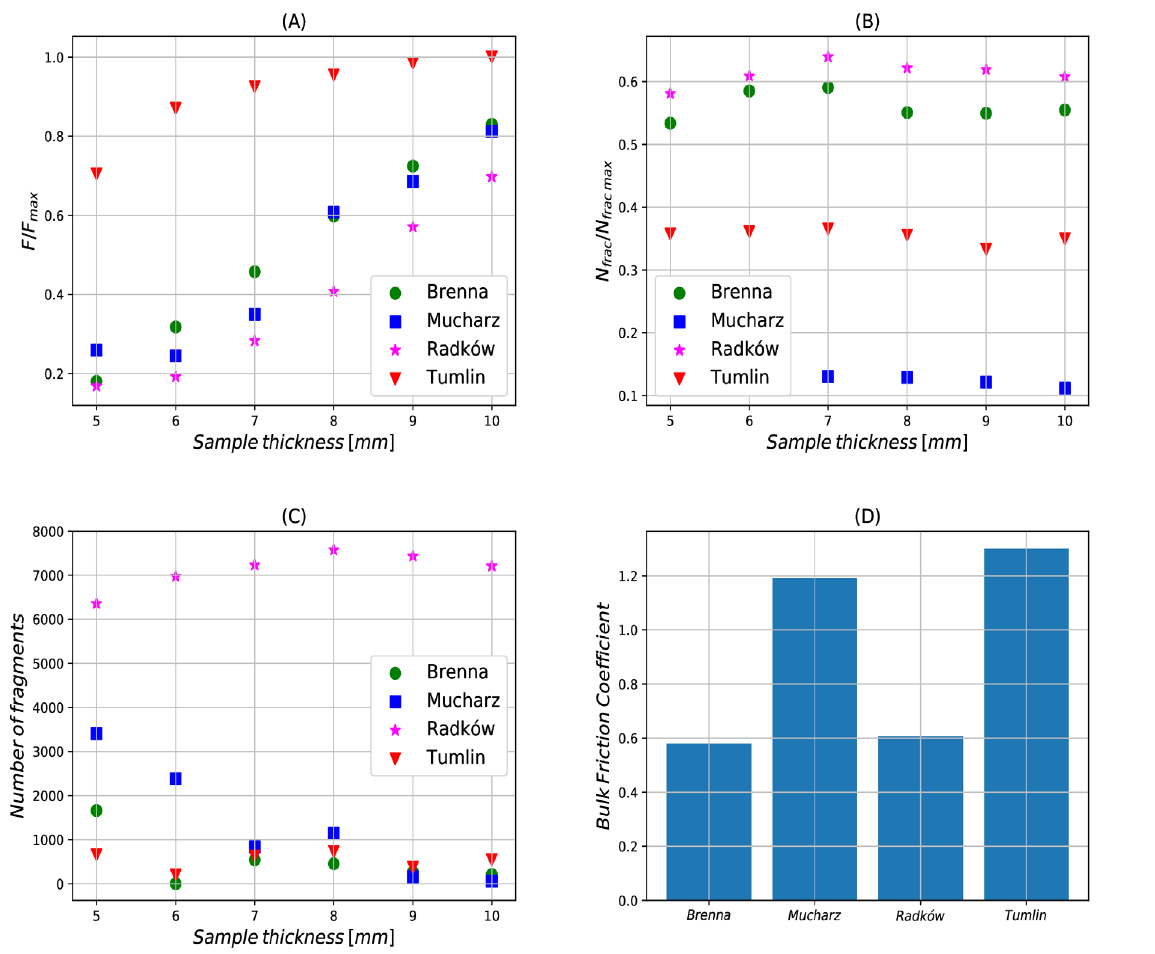
(force divided by maximum max / N (number of fractures frac frac max